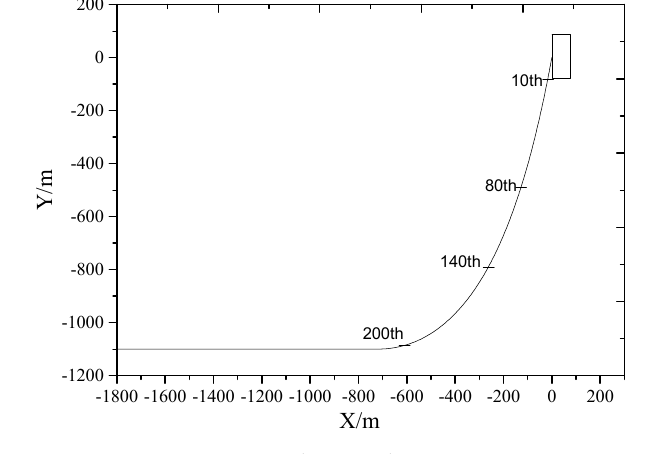
Figure 7. The static location.